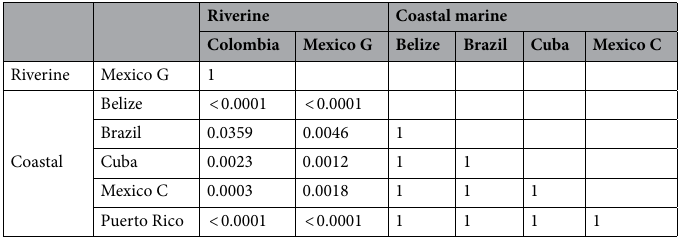
Table 6. Pairwise comparisons among localities for BCI 1 using Wilcoxon rank sum test with Bonferroni continuity